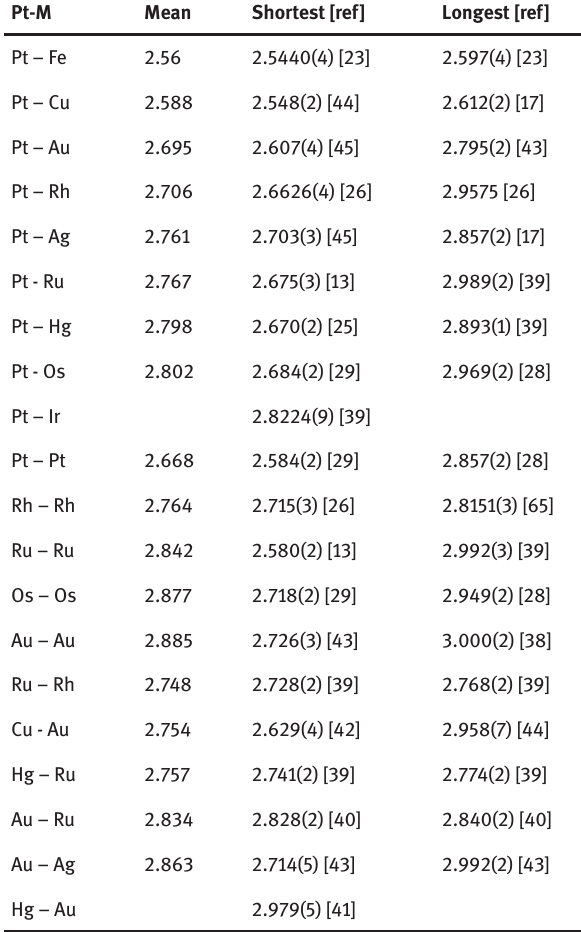
Table 4: Summary of the Pt-Pt, Pt-M and M-M and M-M´ bond distances (< 3.0 Å) in heterodecanuclear platinum